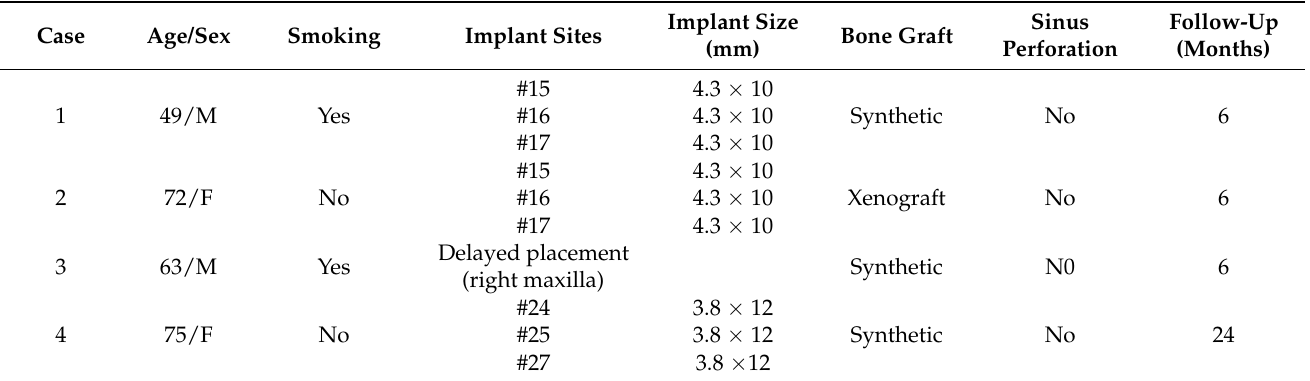
Table 1. Demographic characteristics of patients and information on implants, bone graft, sinus perforation, and